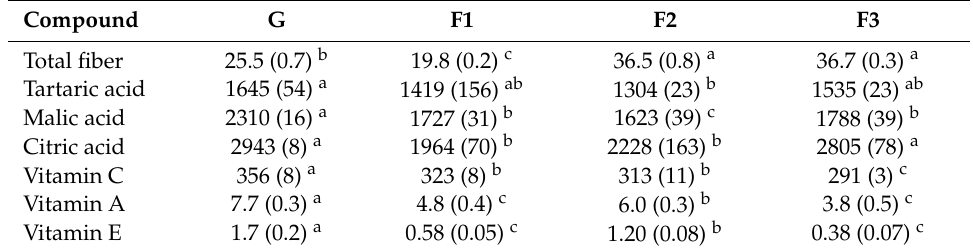
Table 5. Mean values (with standard deviation) of total fiber (g / 100 g) organic acids (mg / 100 g), and vitamins (mg / 100 g) analyzed in grapefruit powder (G) and each grapefruit freeze dried formulation (F1, F2, and